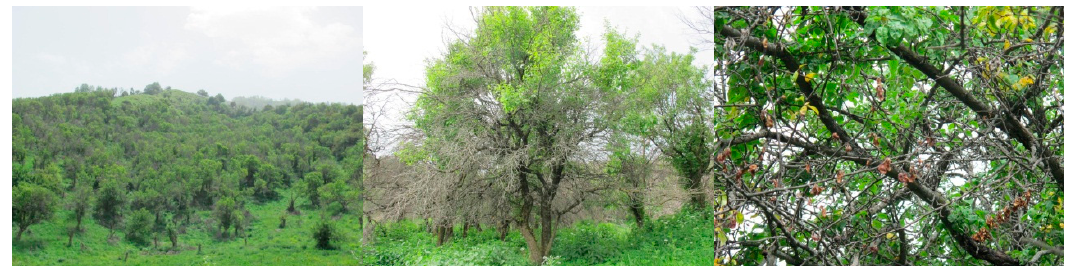
Figure 1. Declining symptoms of wild apple forests in Xinjiang.